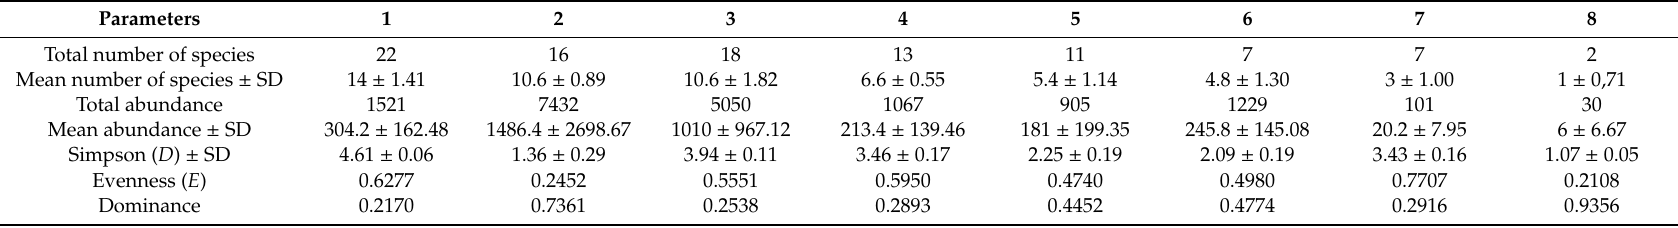
Table 1. Diversity of arthropods along a glacier foreland, Midtre Lov é n glacier, close to Ny-Ålesund. Data are mean per sample ± standard deviation (SD). Parameters 1